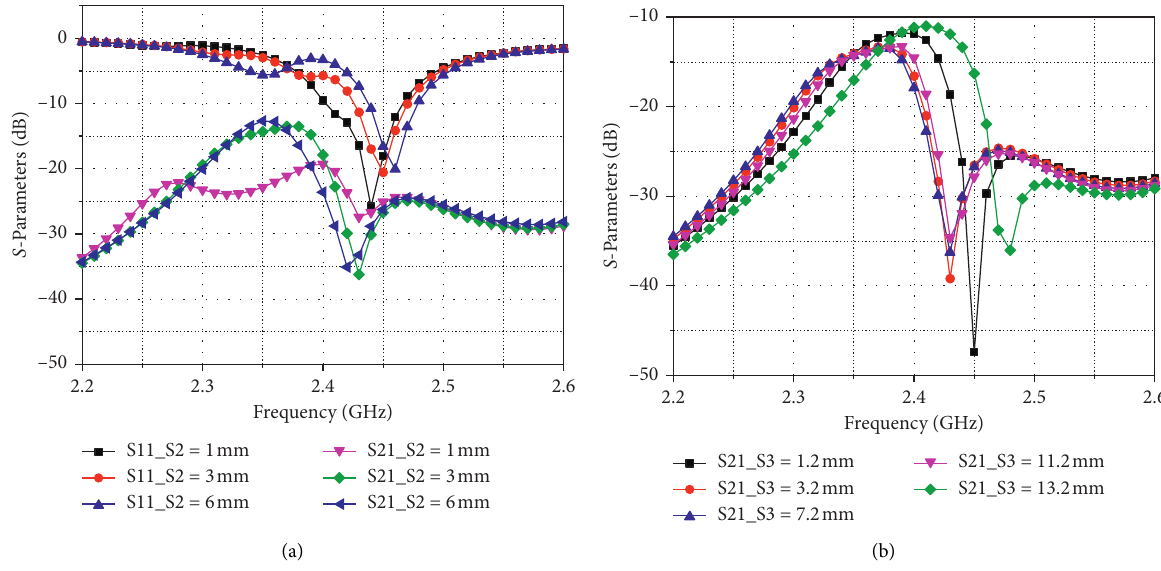
Figure 3: Comparison between the position of the E-shaped stub and S -parameters: (a) spacing between the E-shaped stub and IDLM; (b) the offset of E-shaped stub.